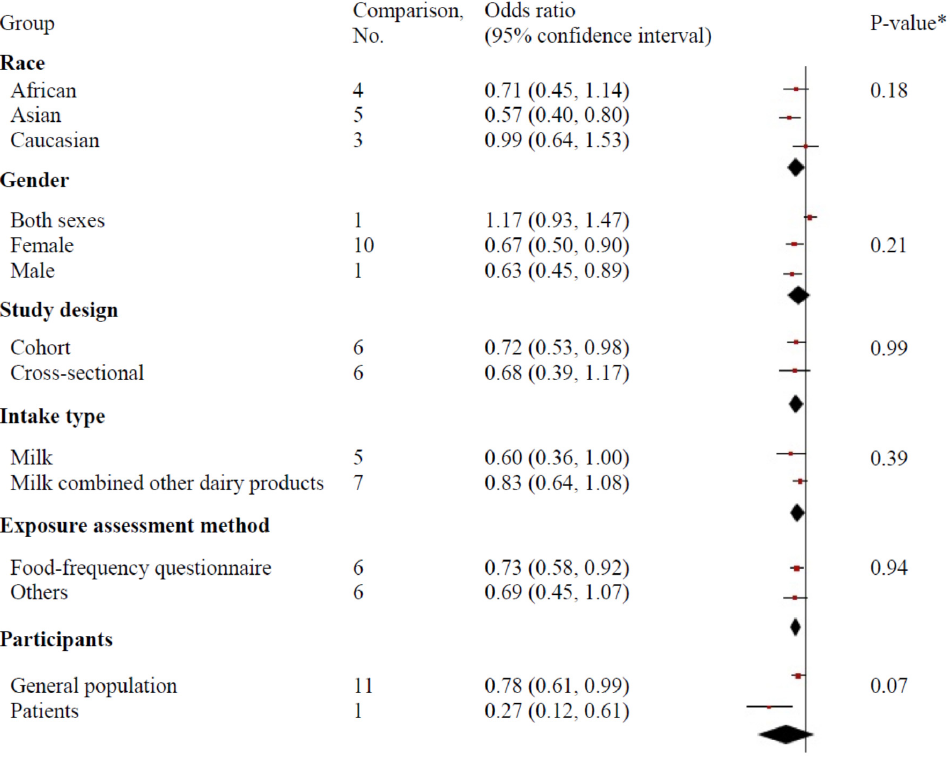
Figure 3. Subgroup analysis of the association between milk consumption and risk of cognitive disorders. * p ‐ value for meta ‐ regression. disorders. * p -value for